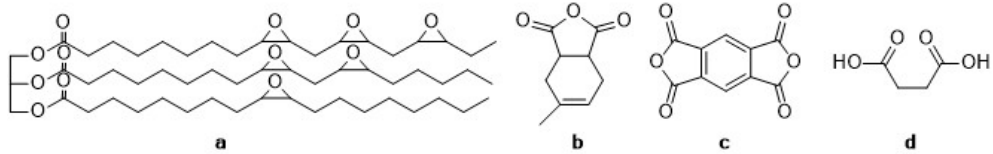
Figure 1. Structural formulae of ( a ) the epoxidized linseed oil (ELO) and the compounds of the hardener system ( b ) methyltetrahydrophthalic anhydride (MTHP), ( c ) pyromellitic dianhydride (PMDA) and ( d ) maleic acid (MA).